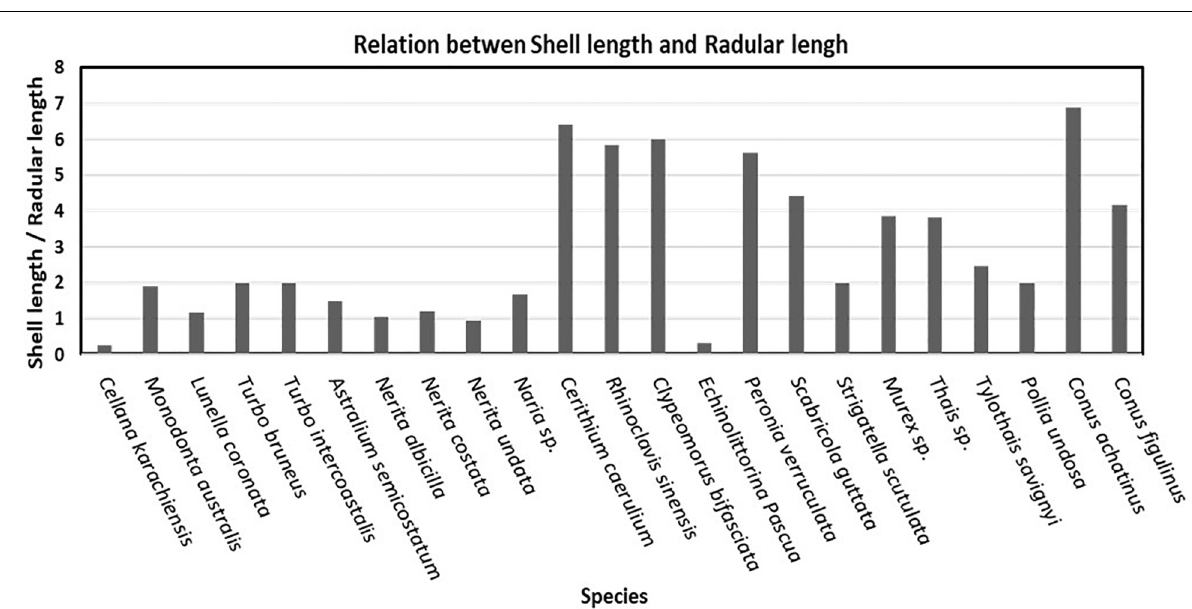
FIGURE 7 | Relationship between shell length and radular length of selected